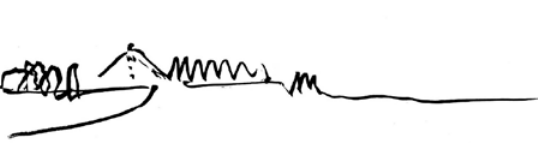
fig. 4. antoine Predock sketch for the american Heritage Center and art Museum, laramie, Wyoming, 1988. ©